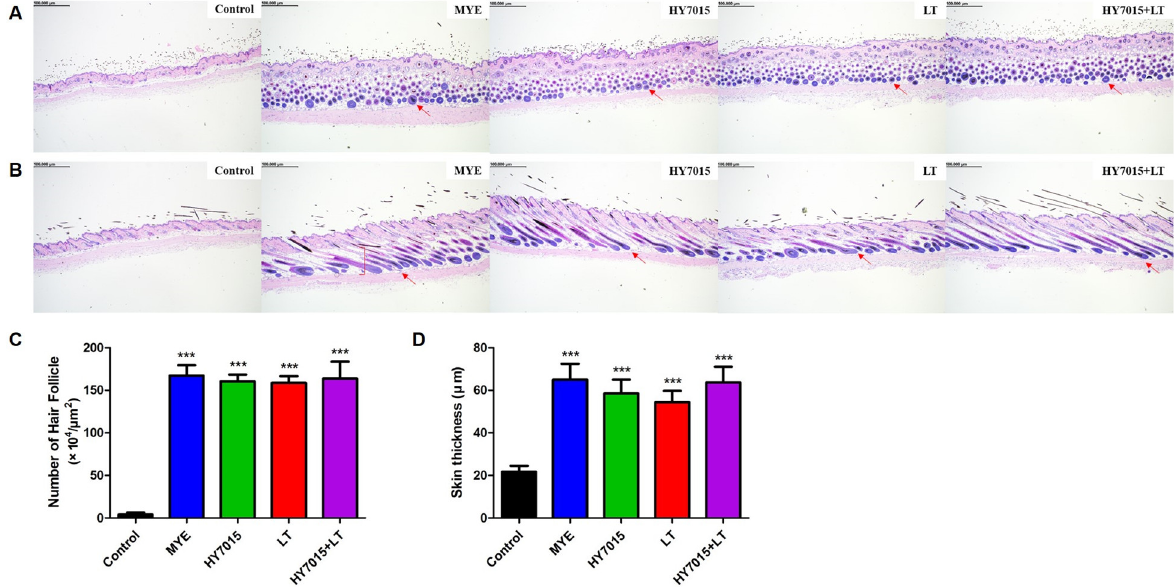
Figure 5. Oral administration of Lactobacillus paracasei HY7015 (HY7015) and/or Lycopus lucidus Turcz. (LT) extract promotes formation of hair follicles in telogenic mice. H&E staining histology analysis of ( A ) transverse sections. Slides were prepared by cutting the skin tissue perpendicular to the tail to observe mouse hair follicles. ( B ) Longitudinal sections for dermal layer thickness measurements of mouse dorsal skin tissues. Arrows indicate the presence of hair follicles in skin. ( C ) Numbers of hair follicles in dorsal skin layer samples (×10 4 /µm 2 ). ( D ) Dermal skin thickness (µm). Data are presented as mean ± SE. Significant differences are indicated by *** p < 0.001, relative to the control group. SE, standard error; MYE, medicinal yeast extract; HY7015, Lactobacillus paracasei HY7015; LT, Lycopus lucidus Turcz.; HY7015+LT, Lactobacillus paracasei HY7015 with Lycopus lucidus Turcz.